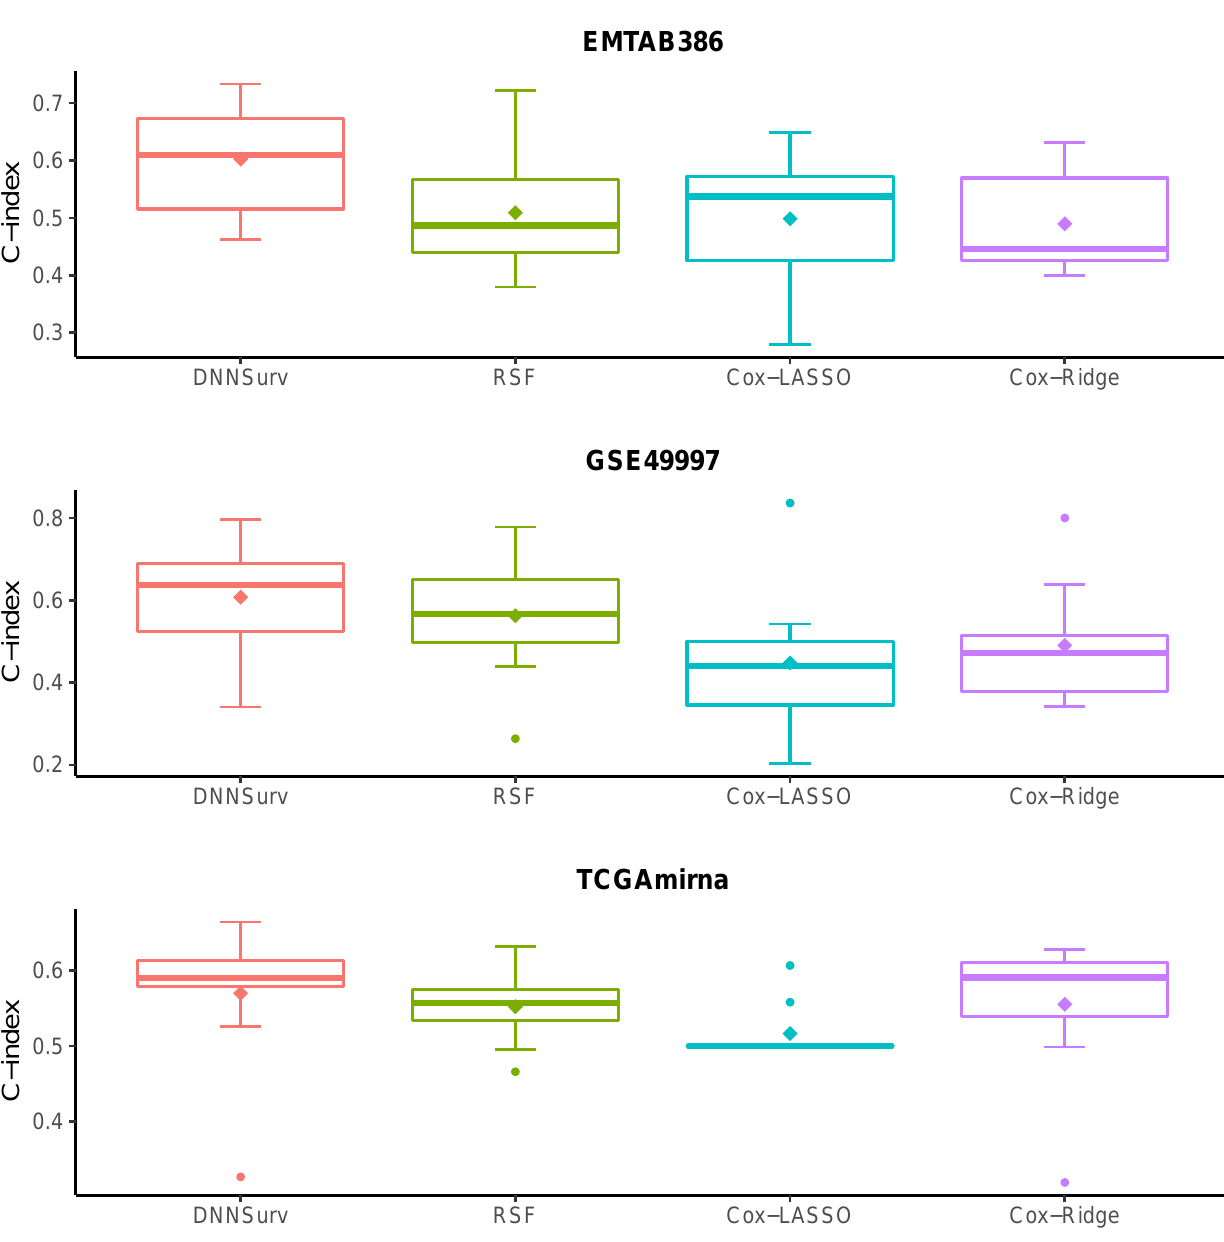
Figure 4. Boxplots of the C-index for four models on three test datasets that contain gene features only